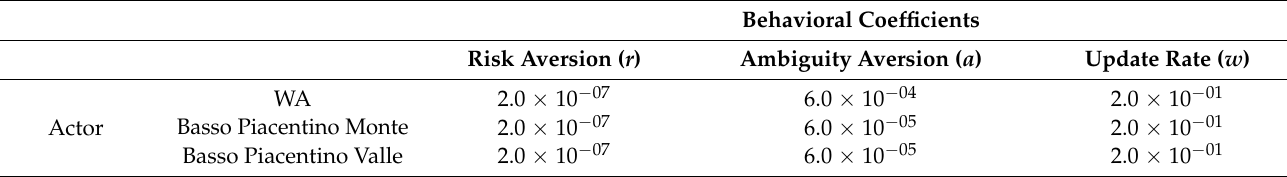
Table 4. Actors’ behavioral coefficients in Scenario